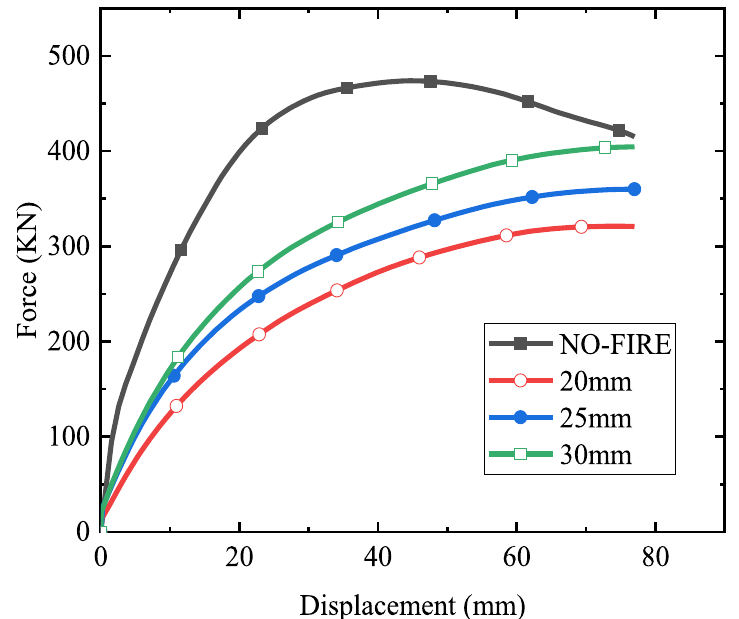
Fig. 41 Load-displacement curves for different